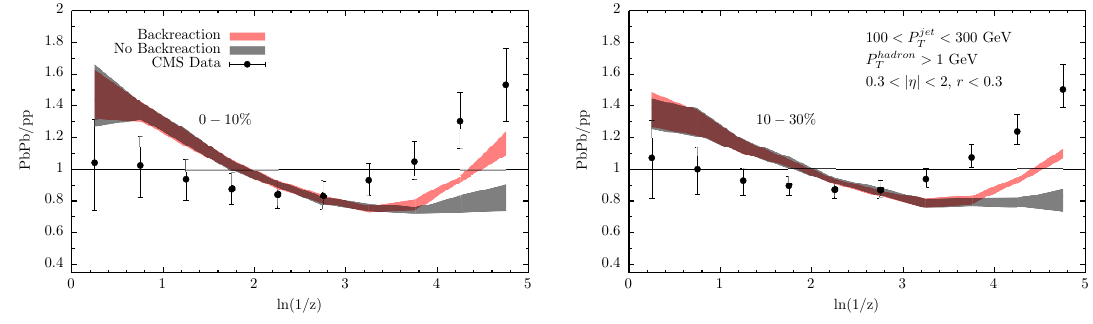
Figure 11 . Ratio of the jet fragmentation function in PbPb collisions at p s = 2 : 76 ATeV to that in proton-proton collisions. As in (cid:12)gure 10, we compare the results of our hybrid model calculation with and without the inclusion of the particles coming from the backreaction of the medium in 0-10% centrality (left) and 10-30% centrality (right) collisions to data measured by CMS